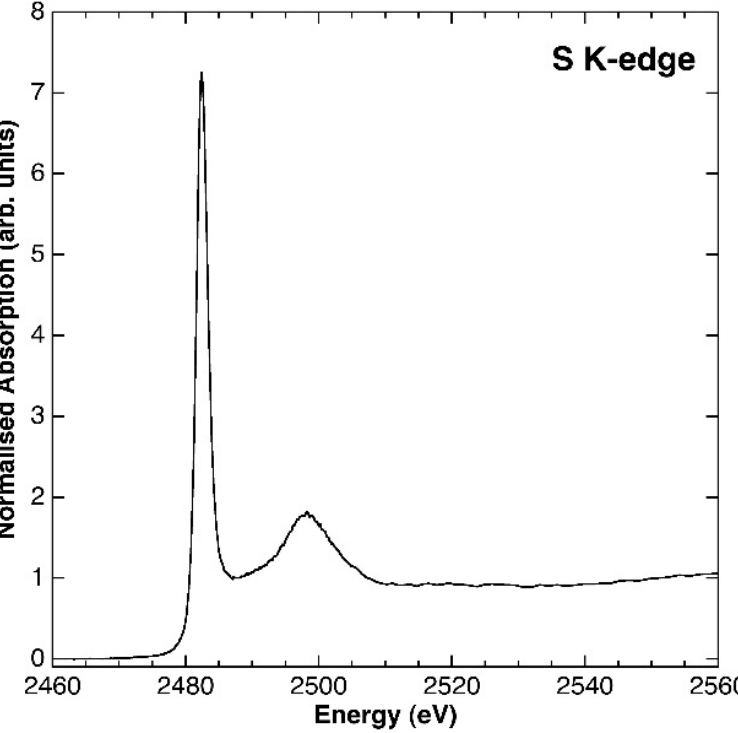
Figure 4. XAS spectrum at the S k-edge of the synthetic woodwardite sample.